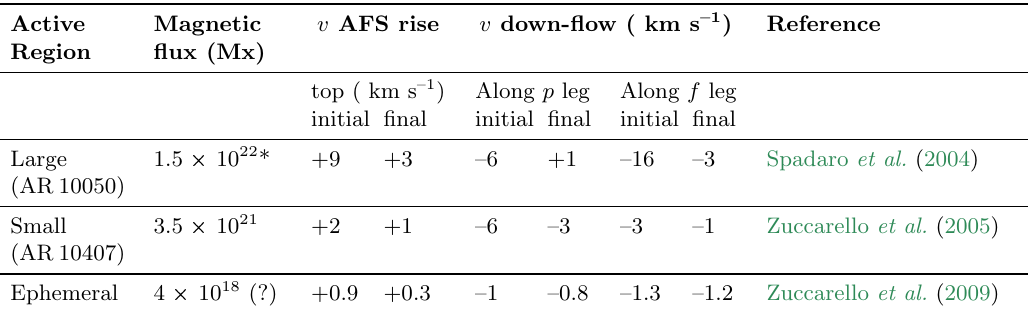
Table 2: Mean velocities measured in Arch Filament Systems (AFSs) in emerging flux regions of different flux classes. The “initial” and “final” values refer to consecutive days in large and small ARs, while in the ER the time difference between these values is only three